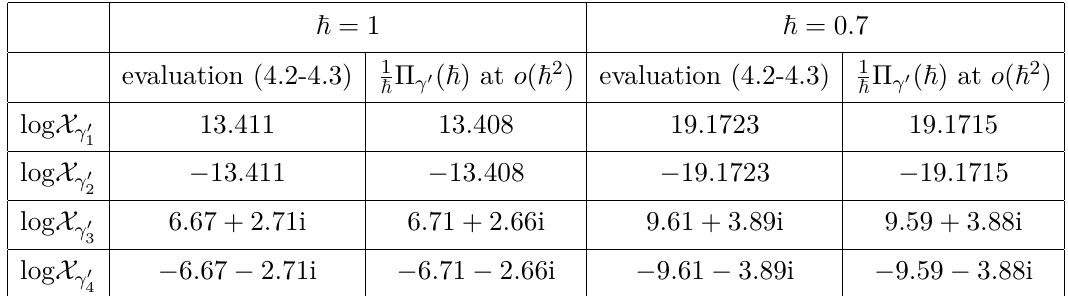
Table 6 . Comparison of log X γ 0 with the formal quantum periods expansion up to order- ~ 2 for equation B of (1.12) at ~ = 1 and ~ = 0 . 7 , where we have set u